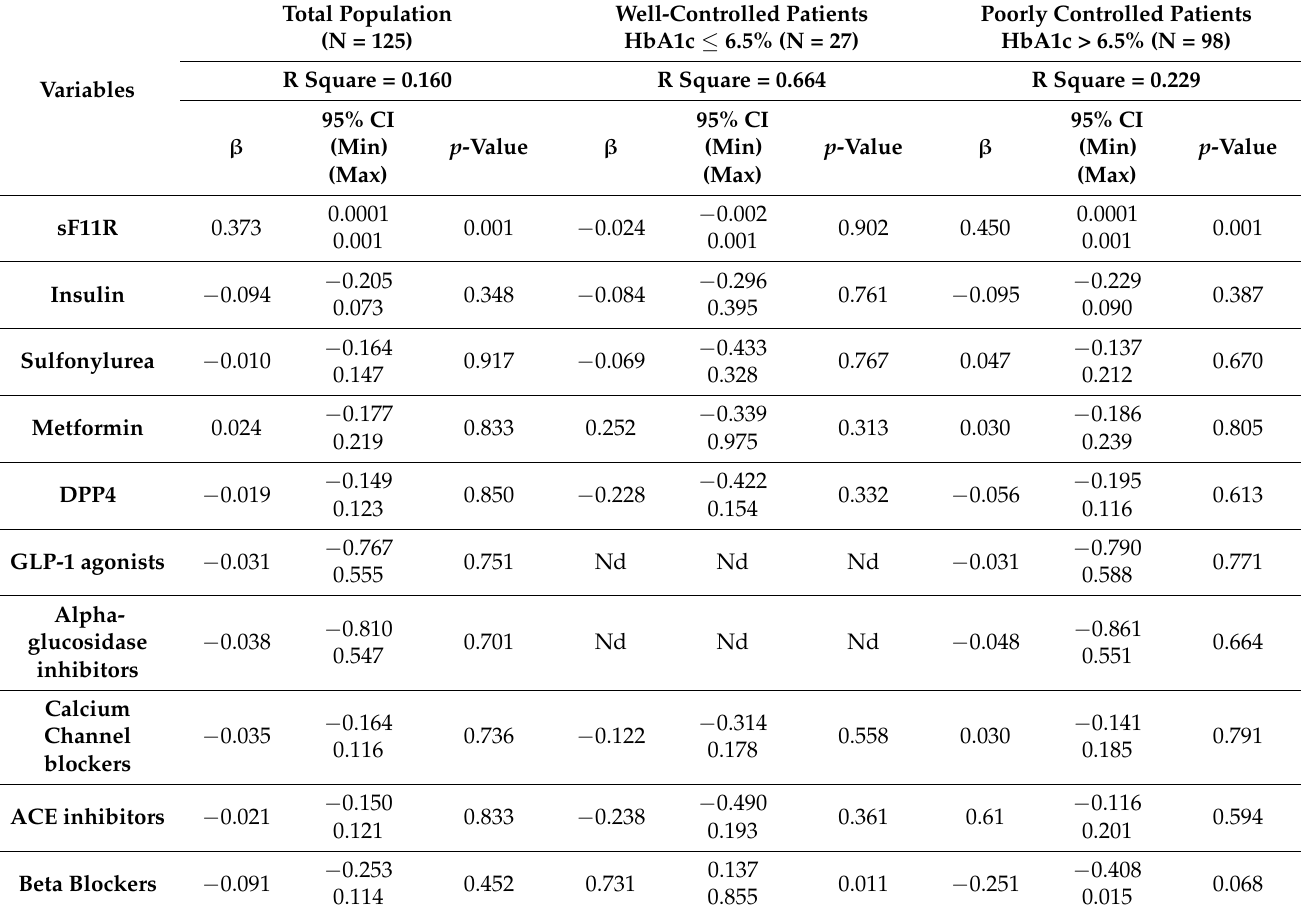
Table 7. Influence of medication on the association between circulating sF11R and ANXA5